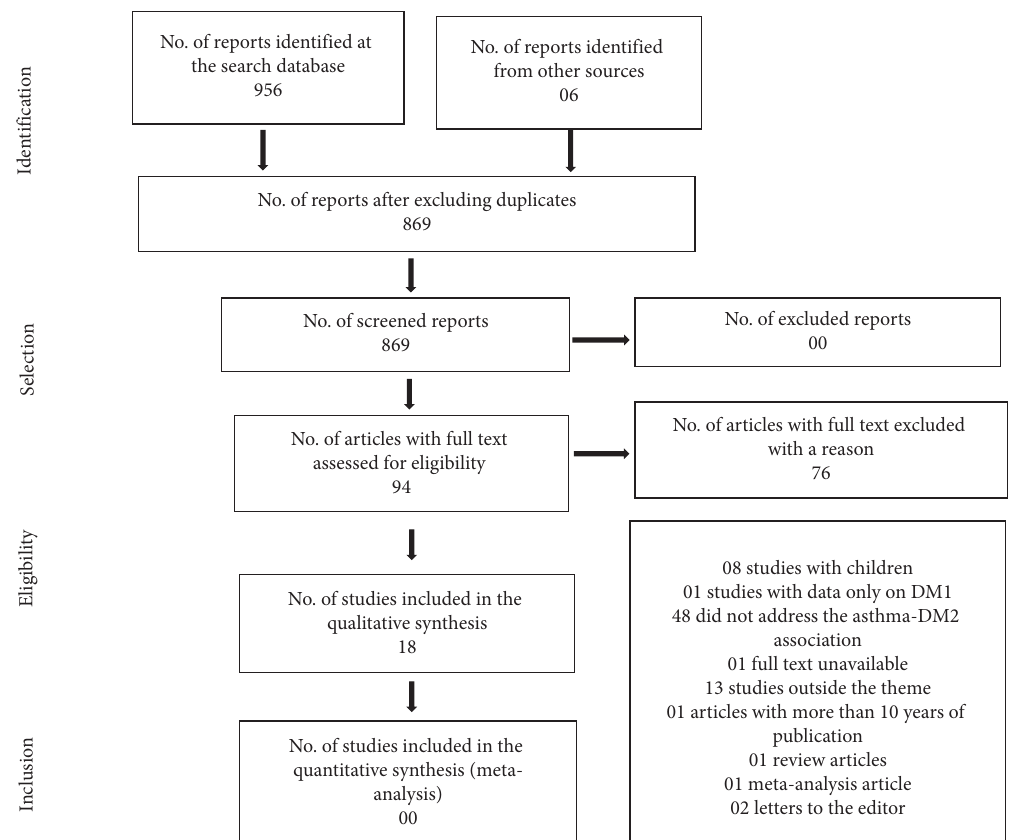
Figure 1: Flowchart of articles included and excluded in the review,